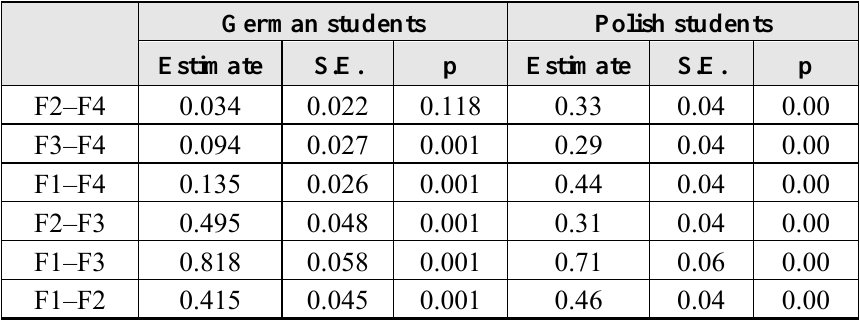
Table 5. Covariance between the respective